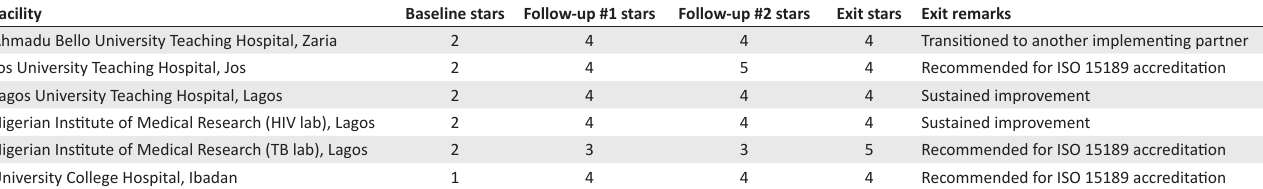
FIGURE 5: Example of a patient history in the treatment response utility. TABLE 3: SLMTA assessment update of Harvard/APIN PEPFAR-supported labs.